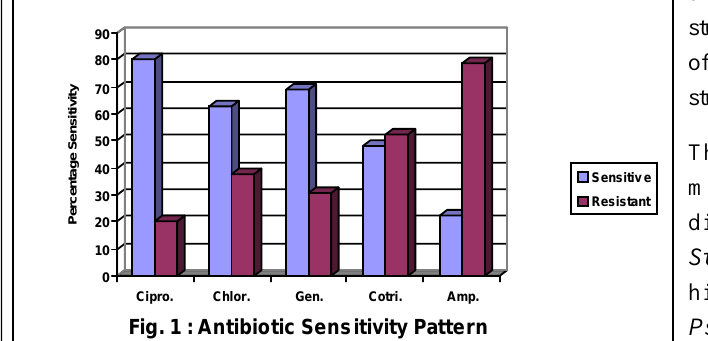
Fig. 1 : Antibiotic Sensitivity Pattern